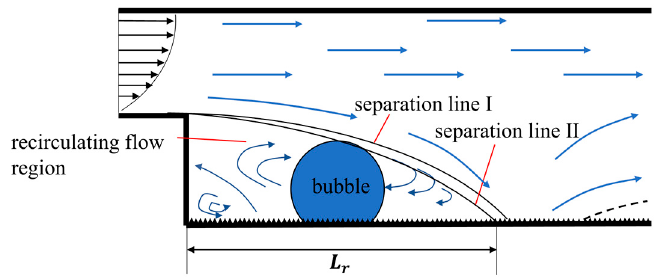
Figure 17. Schematic diagram of the flow field in which the bubbles are located.